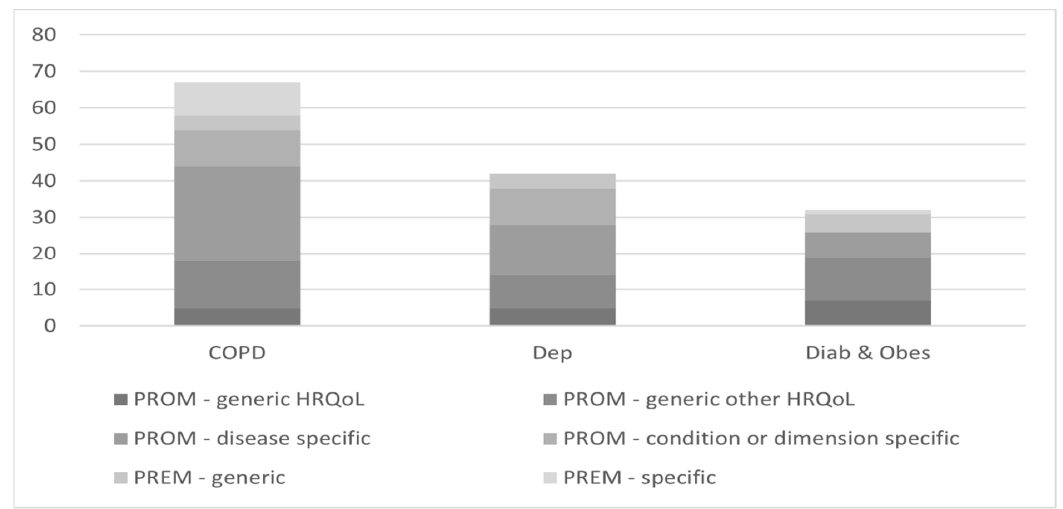
Figure 4. Number of PROMs and PREMS in studies by type of disease.